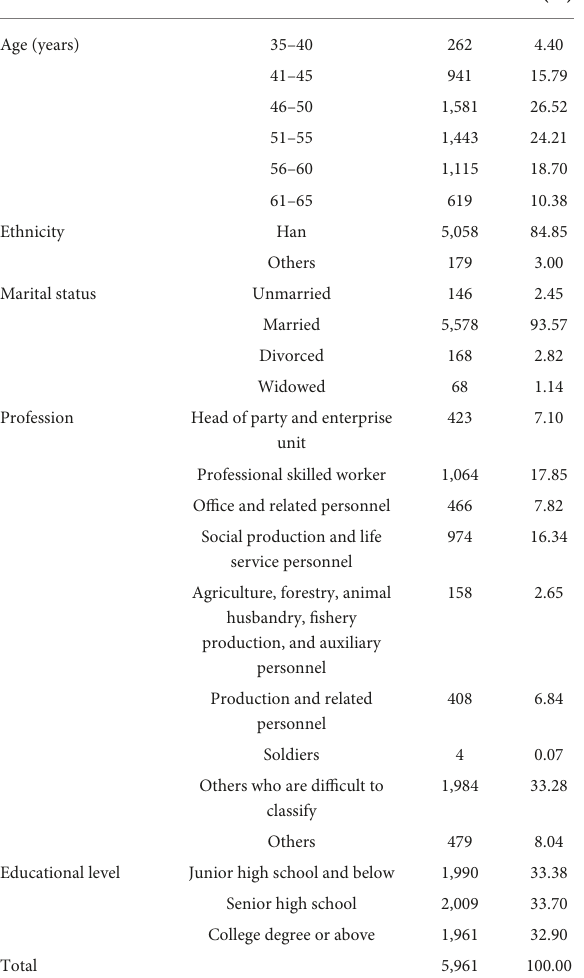
TABLE 1 Basic information of the cervical cancer screening population.